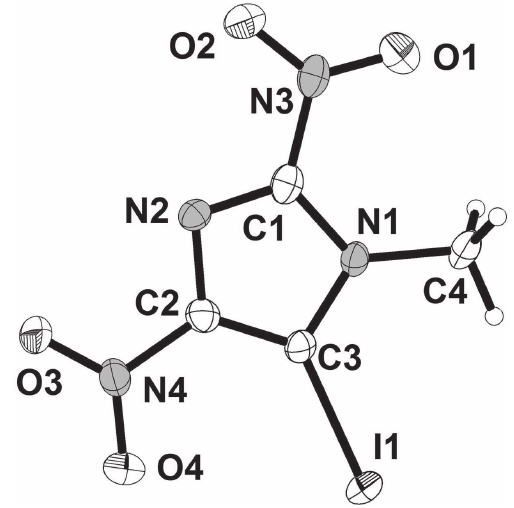
Table 1: Data collection and handling.